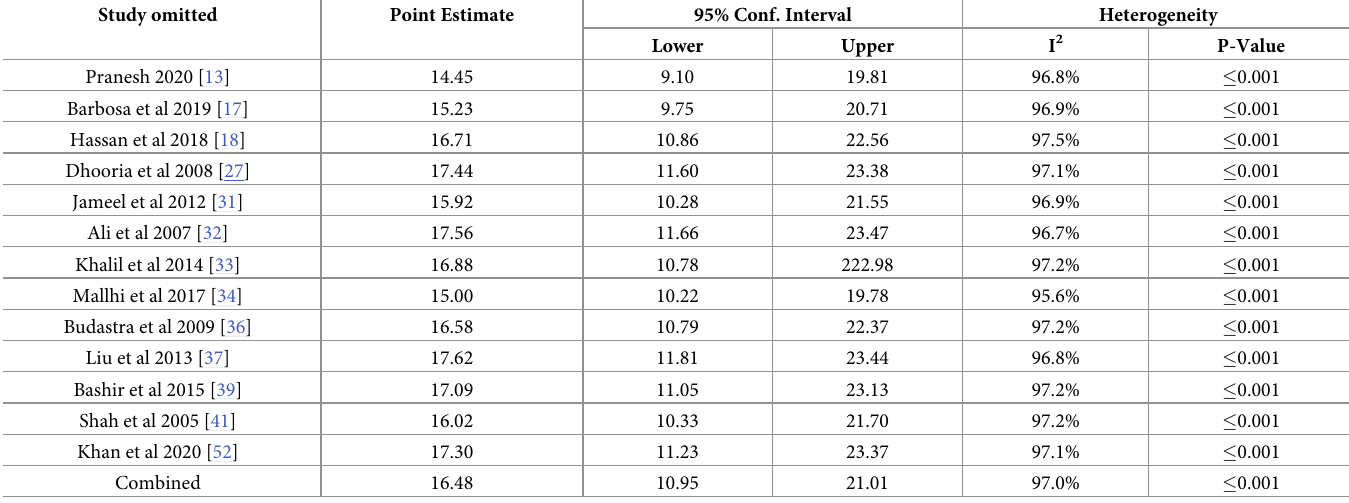
[19]. The non-structural protein 1 (NS1) of the dengue virus can bind both to thrombin and prothrombin. Binding to thrombin will not make any changes whereas prothrombin activa- tion is inhibited. This can explain changes in APTT occur early before antibodies are formed [62]. Coagulopathy as indicated by prolongation of APTT shows an abnormality in the intrin- sic pathway of coagulation which lasts only for few days during the disease course [23]. APTT prolongation in the DF patients is caused by a lack of intrinsic pathway probably due to impaired synthesis of coagulation factor [10]. Reductions in the levels of specific coagulation Table 3. Sensitivity analysis of the included studies to estimate the magnitude of prolonged PT among patients with dengue virus infection. Study